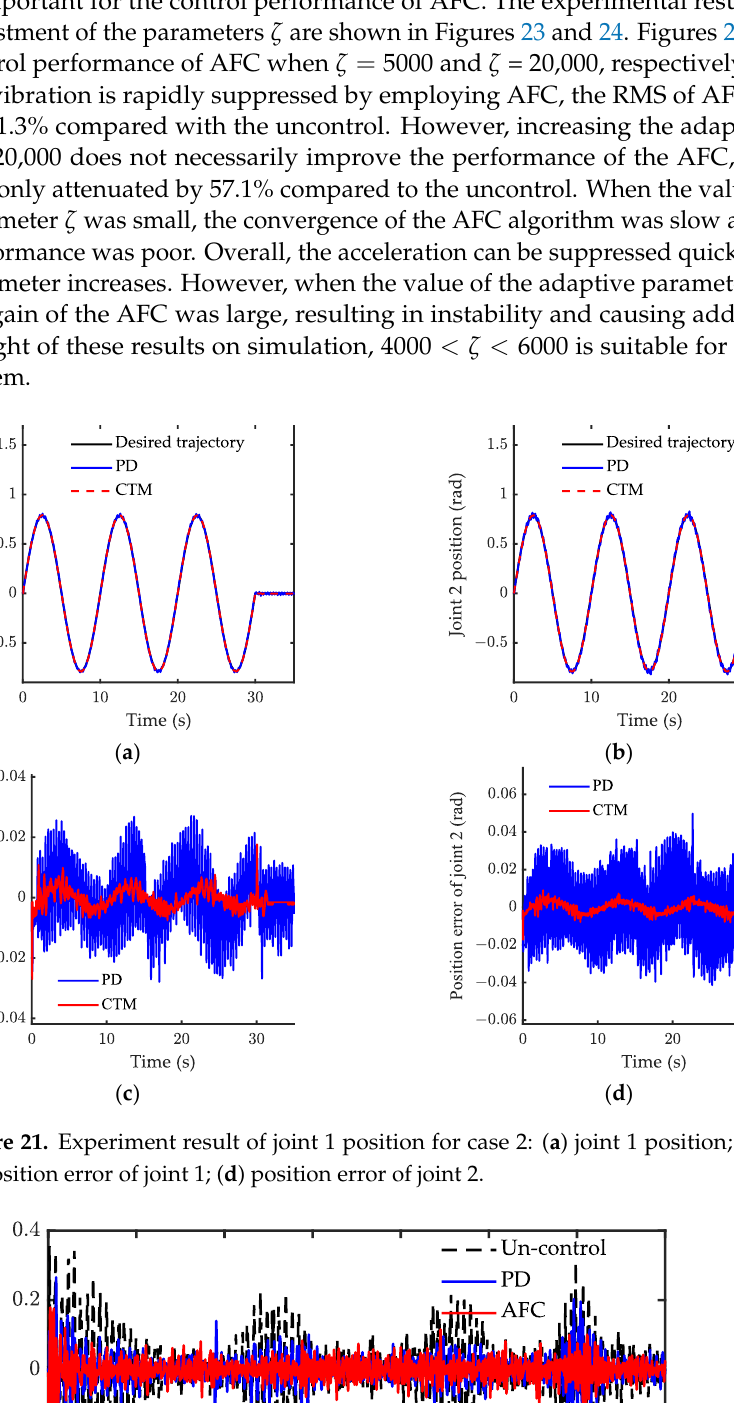
Figure 22. Experiment result of acceleration response for case 2 ( ζ = 2 , 000 ).